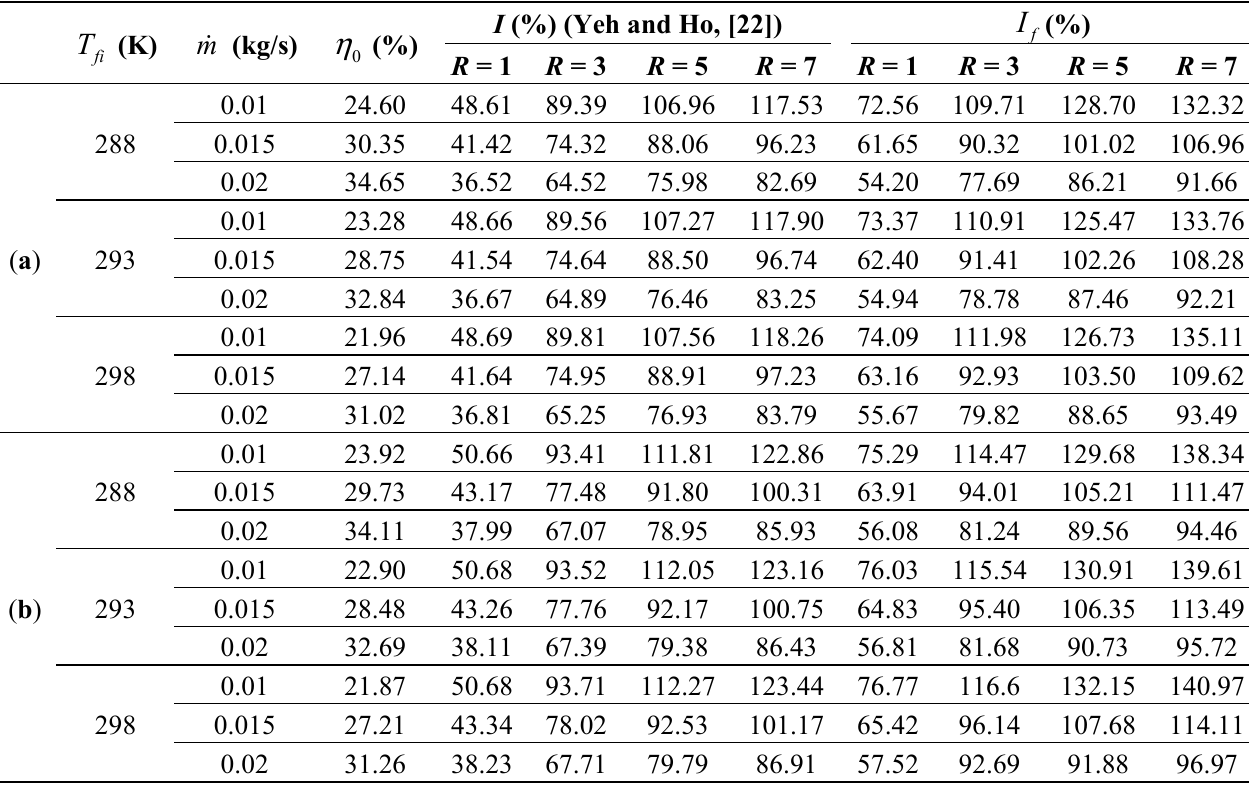
Table 2. The improvements of performance for: ( a )